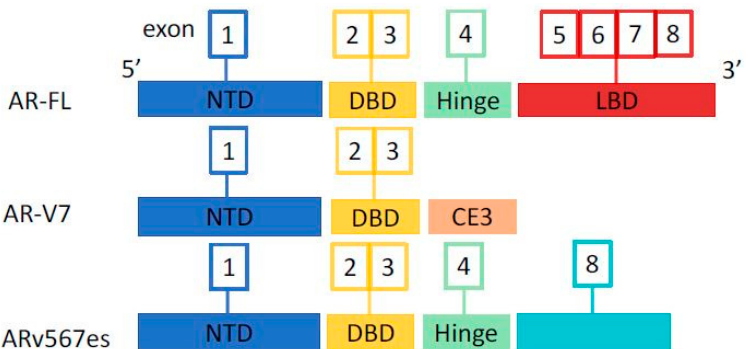
Figure 1. Androgen receptor (AR) and splice variants. AR-FL: AR full length. NTD: N-terminal domain. DBD: DNA-binding domain. LBD: ligand binding domain. CE3: cryptic exon 3.